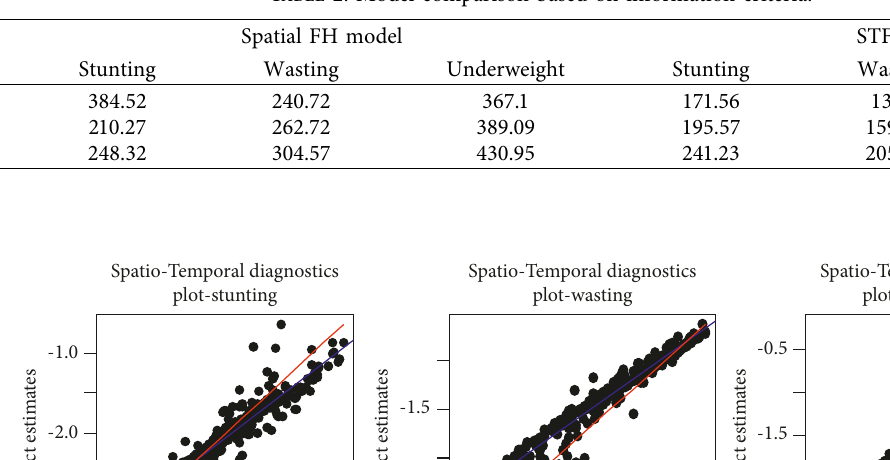
Table 2: Model comparison based on information criteria.